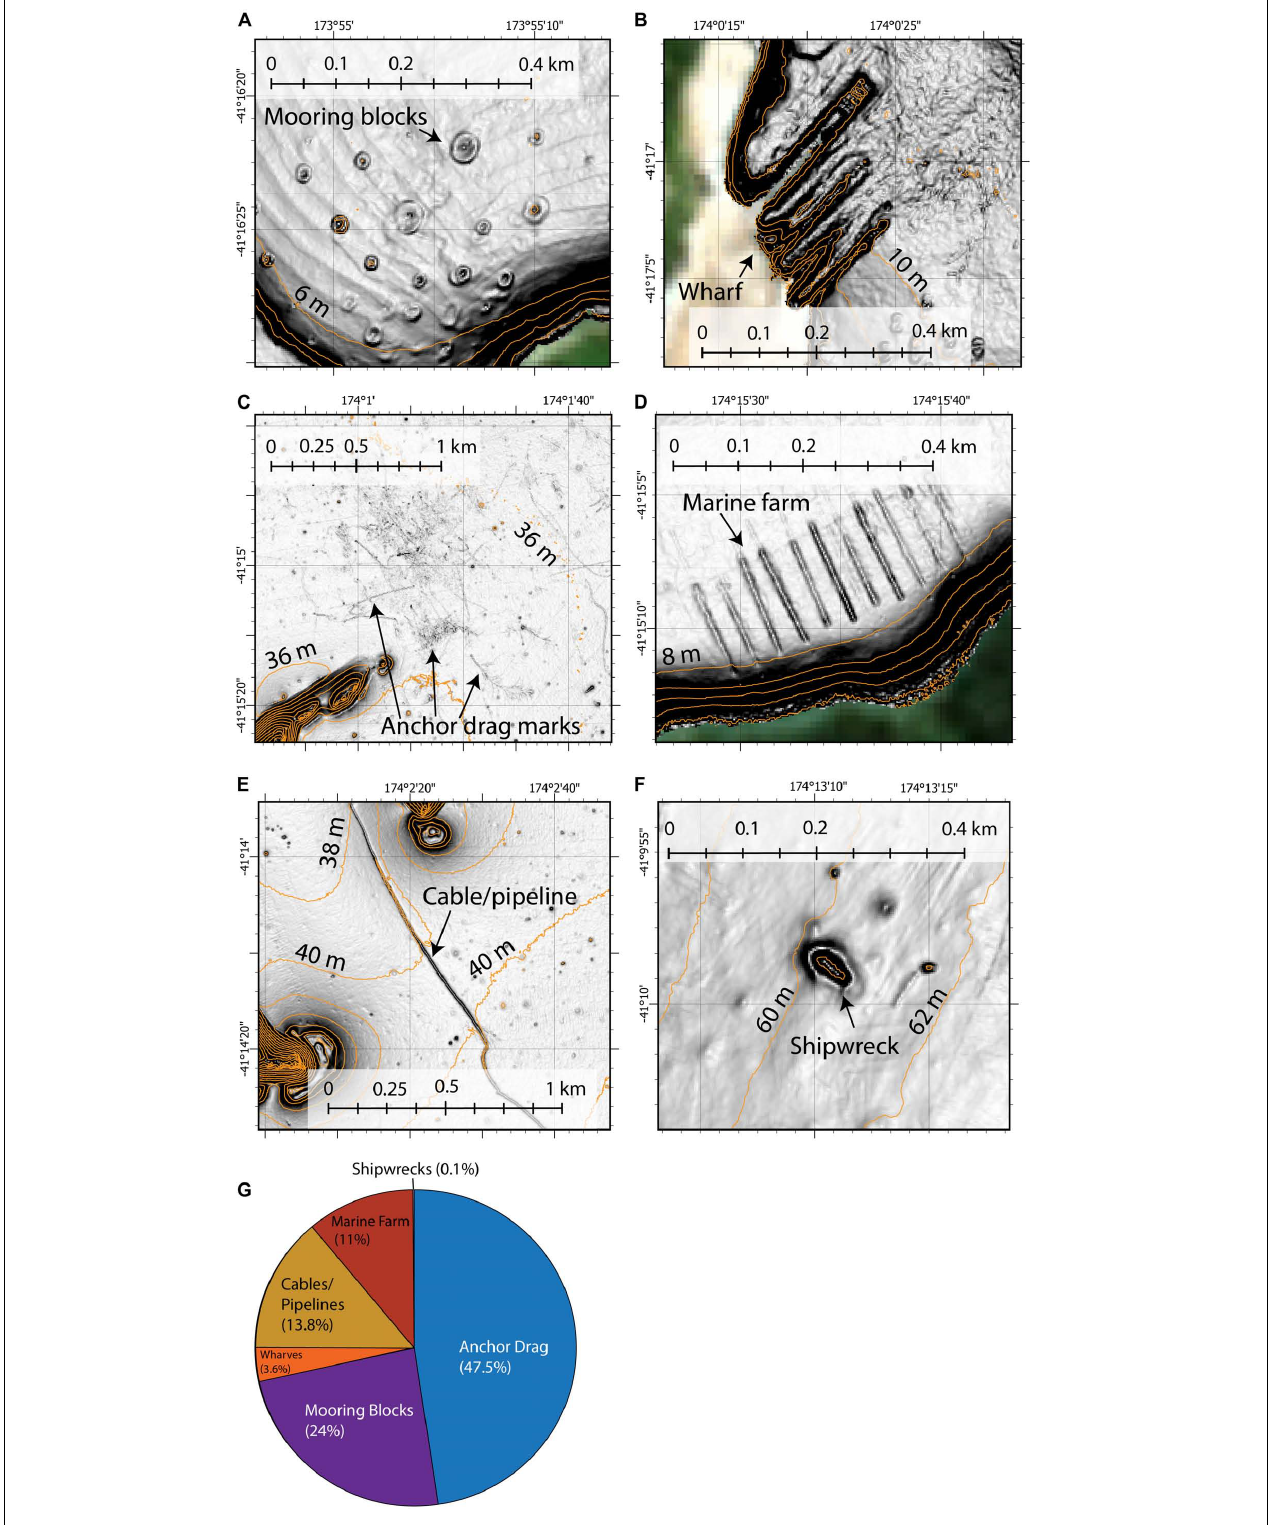
FIGURE 4 | Hill-shaded examples of the anthropogenic footprint observed in the QCS and TC; orange lines are 2 m contours. (A) mooring blocks in the inner QCS, (B) wharves near Picton Port, (C) anchor drag marks at the Picton Anchorage, (D) marine farm in TC, (E) seafloor cable or pipeline in inner QCS, (F) shipwreck in the central QCS, (G) pie chart showing the different types of anthropogenic footprint observed in the QCS and what proportion of area they contribute as a percentage.